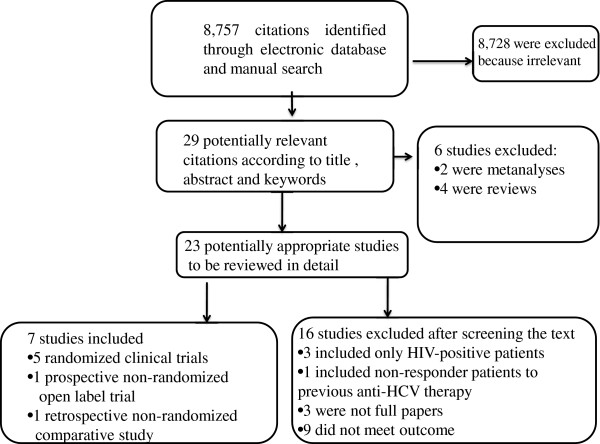
Flow chart of the published studies evaluated for inclusion in the meta-analysis.